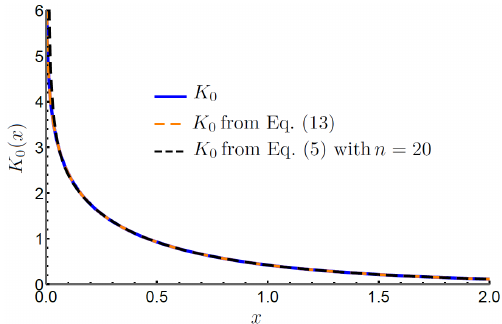
Figure 2. Plot of Equations (13) and (5), up to O ( x 20 ) .